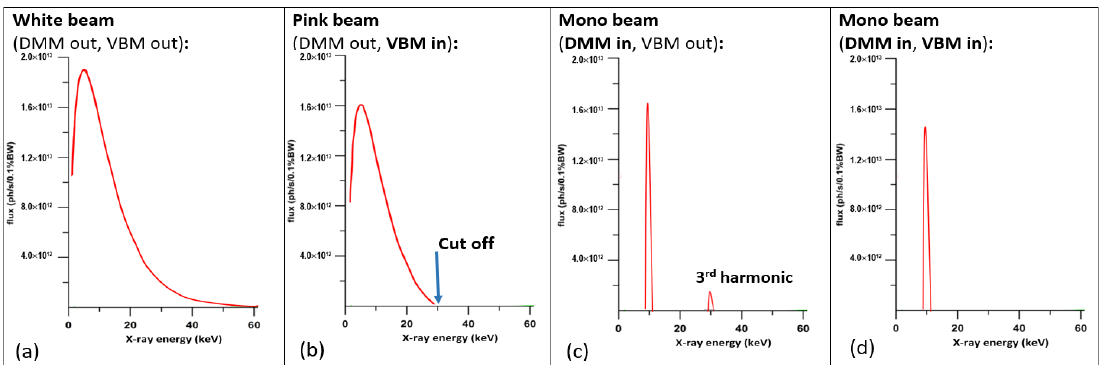
Figure 1. Four different beam modes in MCT beamline: ( a ) white beam, ( b ) pink beam, ( c ) monochromatic beam, and ( d ) monochromatic beam without a third harmonic contribution.